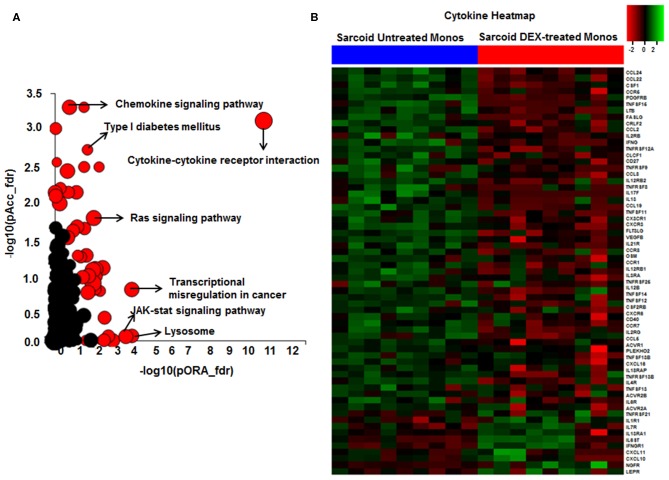
Significant pathways enriched in DEX-treated compared to untreated sarcoid monocytes. (A) Pathway analysis was done on the DE genes (log2FC > 0.6 and FDR < 5%) using iPathwayGuide analysis tool that uses two types of evidence: the over-representation on the horizontal axis (pORA) and the perturbation on the vertical axis (pAcc). Significant pathways (FDR < 5%) are shown in red, whereas non-significant are in black. The size of the circle is proportional to the number of genes in that pathway. (B) Heat map of DE genes involved in cytokine-cytokine receptor interaction pathway (log2 FC > 0.6 with FDR < 5%). Green shade represents high expression and red shade represents low expression.